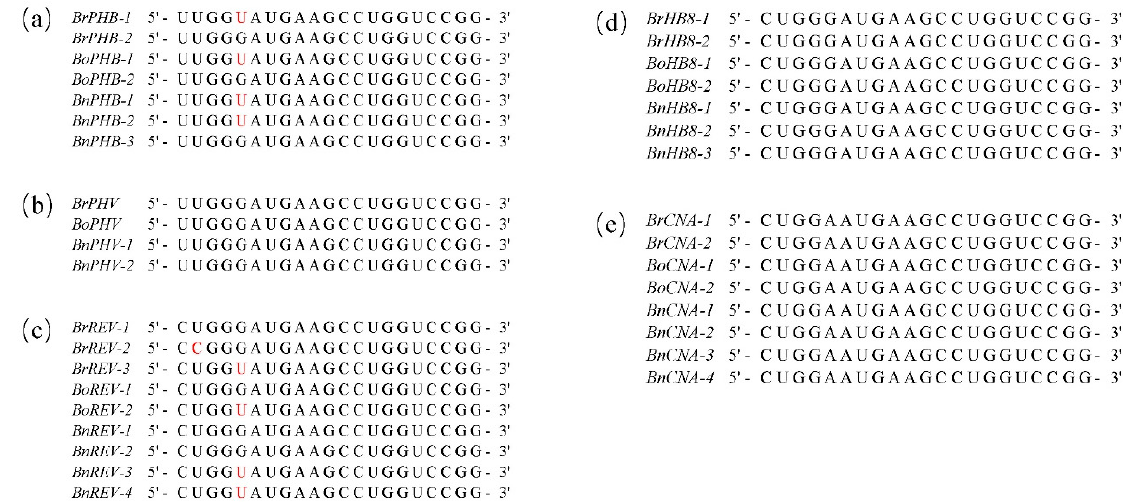
Figure 7. Overview of the miR165/166 target sequences variation in the HD-ZIP III genes. Alignment of the miR165/166 putative target areas of PHB ( a ), PHV ( b ), REV ( c ), HB8 ( d ) and CNA genes ( e ). Red indicates the genetic variation of the miR165/166 target sites.